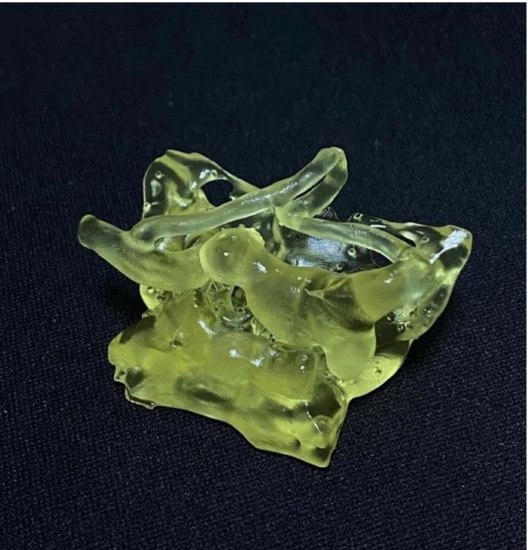
Figure 3. Final 3D printed model of a complex aneurysm of Posterior Communicating